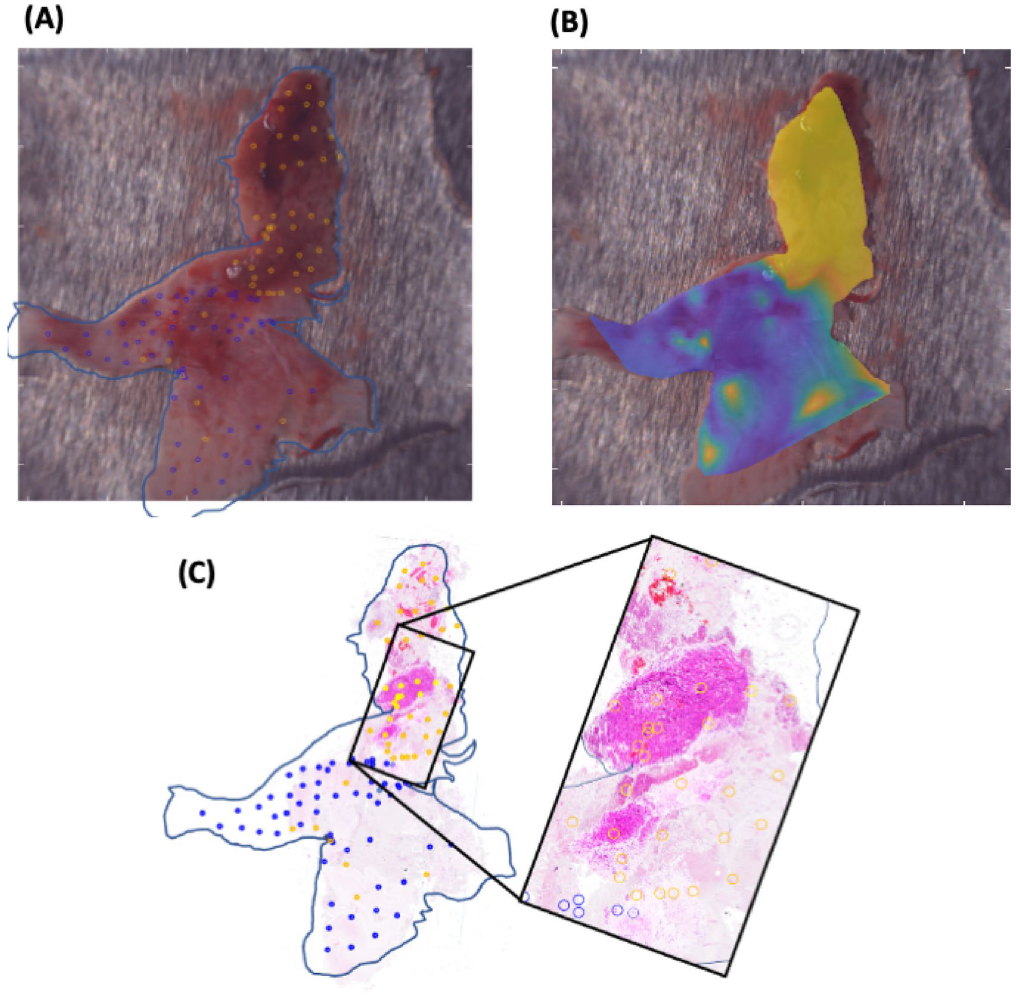
Figure 5. Histological verification of the meningioma-dura mater-classifier. (A) Visible Light Image (VLI) exported from the Solais with engraved measuring points and with a retraced frame. (B) Same VLI superimposed by a classifier heat map with color scale ranging from blue (not meningioma tissue) to yellow (meningioma). The greenish parts are the transition zones between the meningioma tissue and dura mater. (C) Superposition of 21 hematoxylin & eosin stained slides of the same sample with the tumor infiltration zoom-in window and measuring point